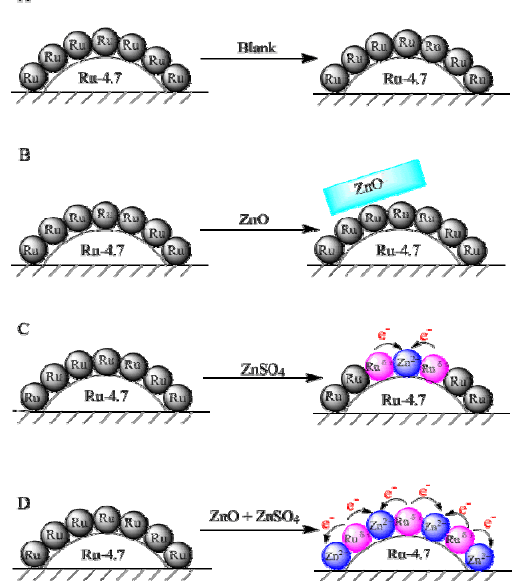
Figure 8. Sketch of surface structure of Ru-4.7 catalysts with the different additives. ( A ) surface structure of Ru-4.7 without any additives; ( B ) surface structure of Ru-4.7 with only ZnO as a reaction additive; ( C ) surface structure of Ru-4.7 with only ZnSO 4 as a reaction additive; ( D ) surface structure of Ru-4.7 with both ZnO and ZnSO 4 as reaction additives.